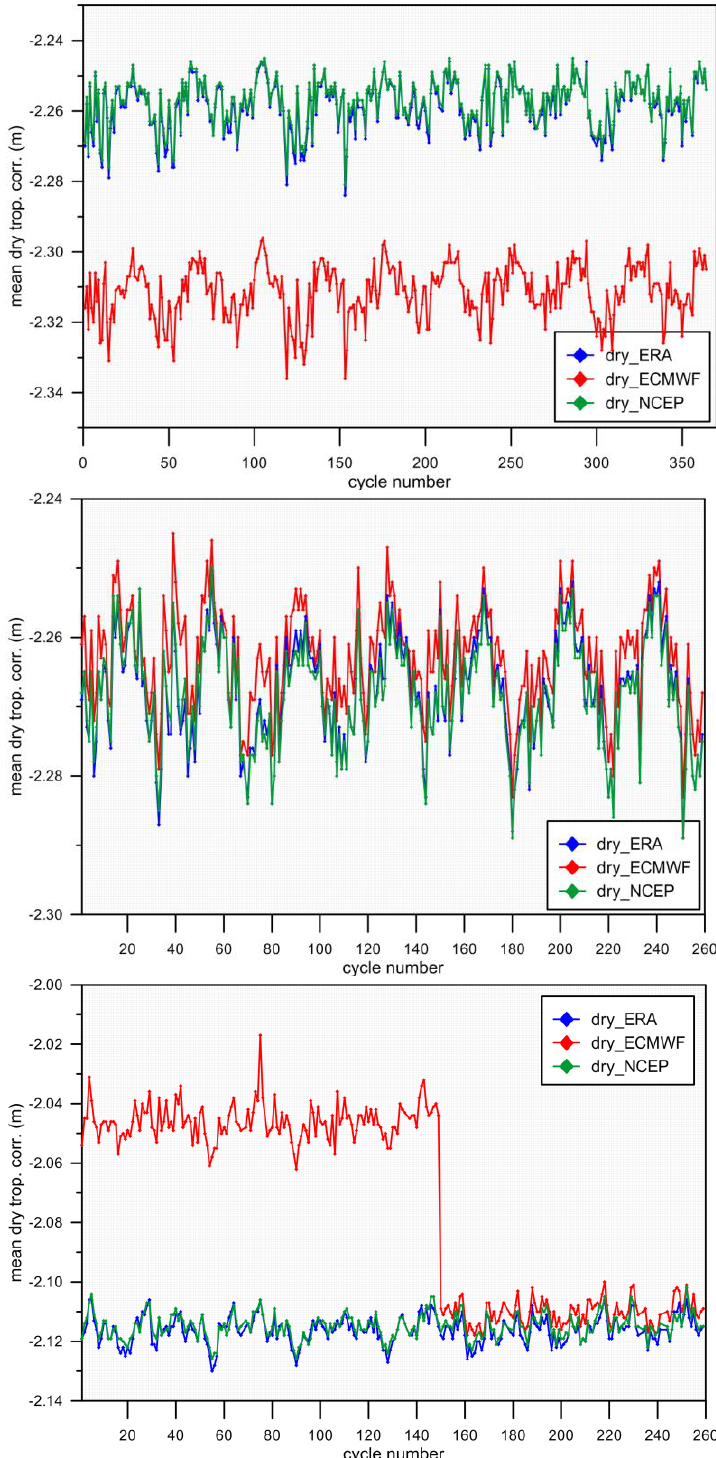
Figure 5. Mean cycle values of the dry tropospheric correction (mean value of the DTC for all selected inland water points of each cycle, ~10 days) from the ECMWF operational model (red), ERA interim (blue) and NCEP (green), in meters, versus the cycle number, for T/P Cycles 1 to 364 ( top ), for Jason-1 Cycles 1 to 259 ( middle ) and for Jason-1 Cycles 1 to 259 Pass 222 over lake Tanganyika ( bottom ). See the main text for further